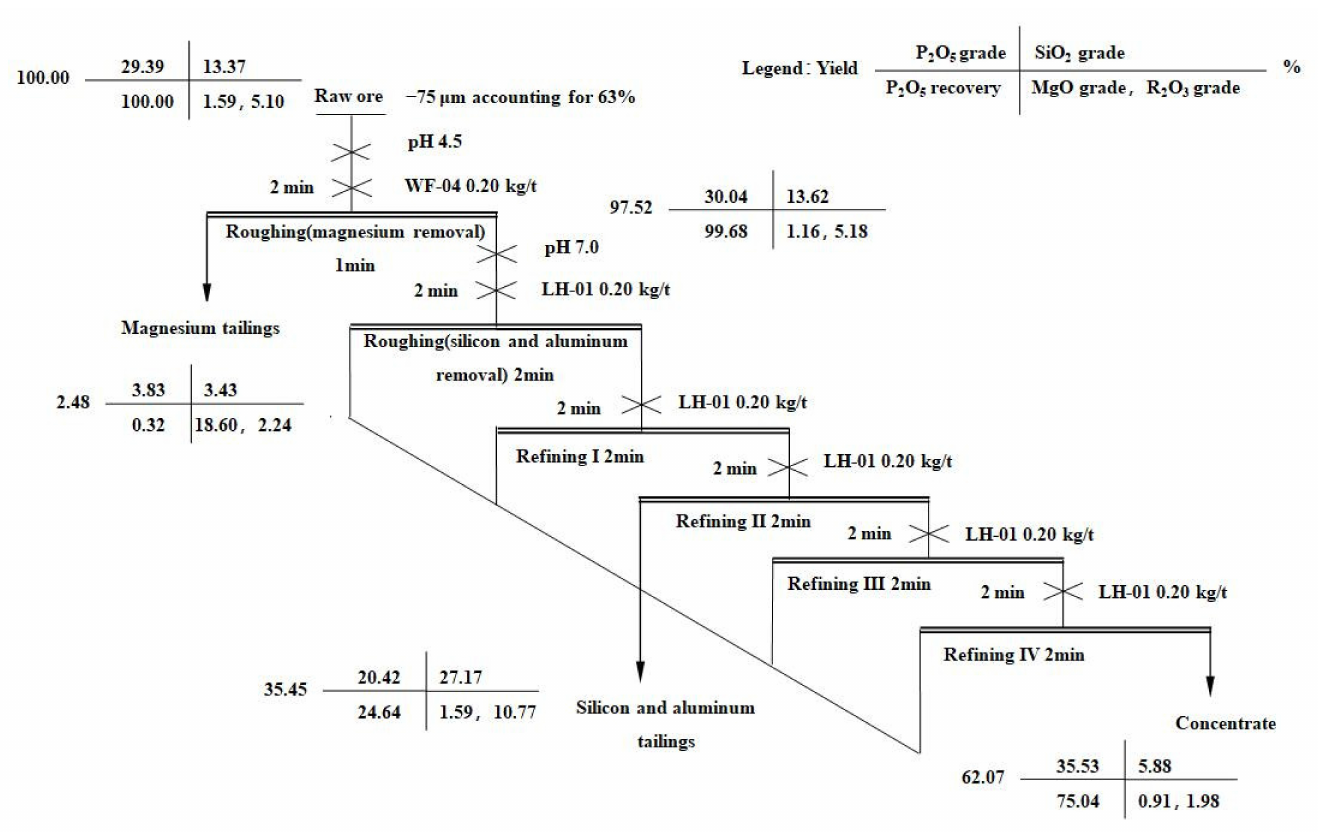
Figure 13. Numerical quality flow chart of double reverse flotation of collophanite with particle size of − 75 µ m accounting for 63%.